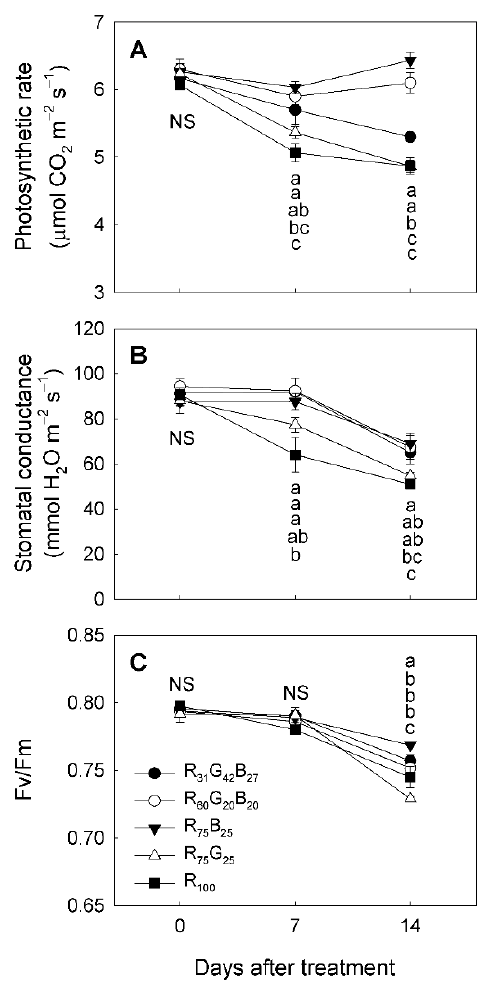
Figure 3. ( A ) Photosynthetic rate, ( B ) stomatal conductance, and ( C ) Fv/Fm of Ocimum basilicum grown under five different combinations of red, green, and blue LEDs with the same light intensity for 14 days. The numbers after each waveband indicate the ratios of the intensities. The R 31 G 42 B 27 treatment mimics the sunlight spectrum measured in the experimental greenhouse. Mean separation followed analysis of variance (ANOVA) with Duncan’s multiple range test at α = 0.05. Means with the same letter are not significantly different. Error bars indicate the standard error ( n =